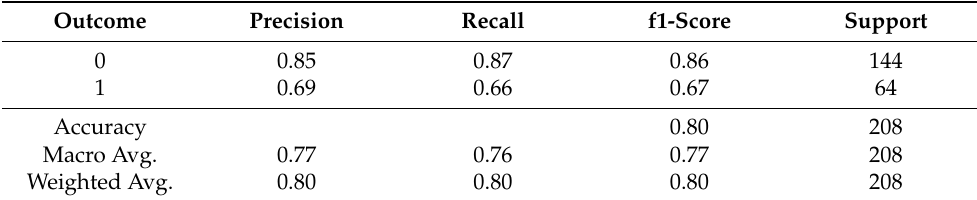
Table 5. Classification report table for the estimated